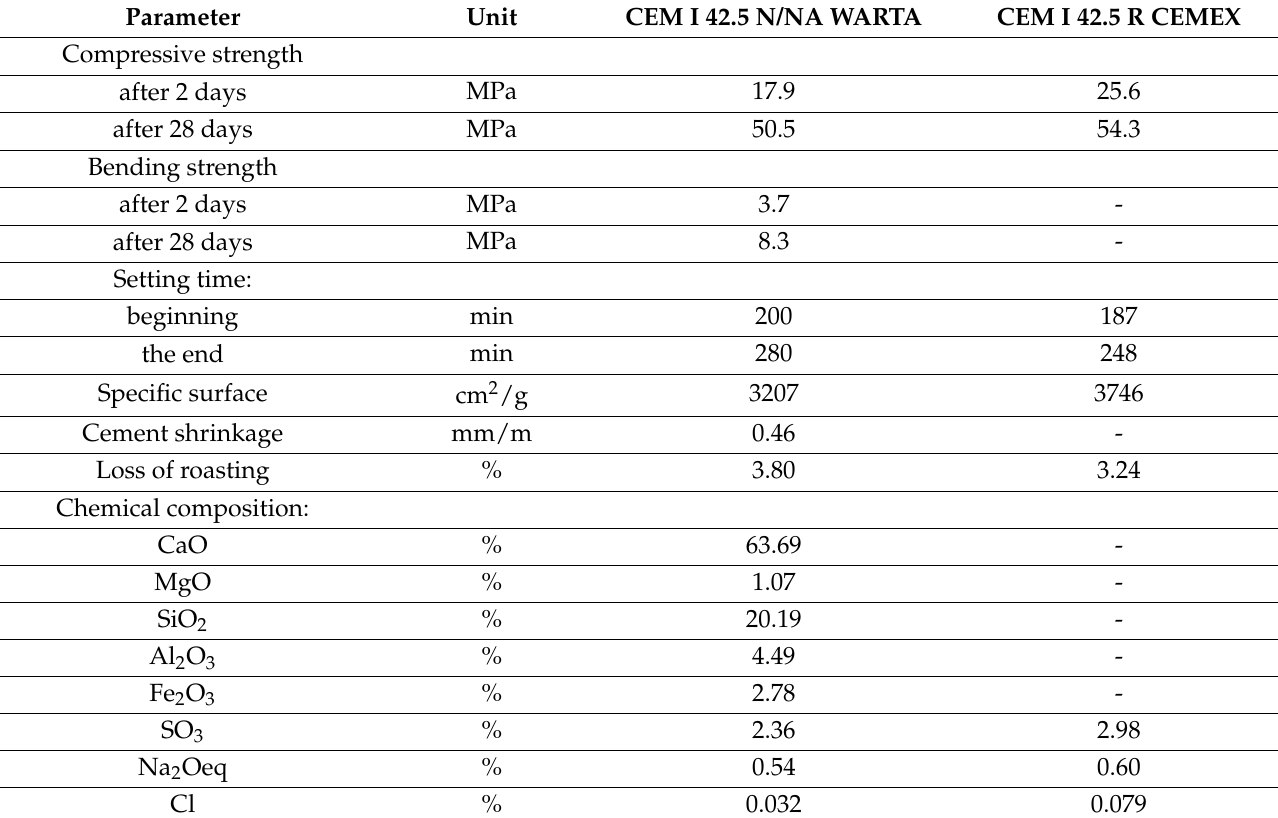
Table 1. Properties of